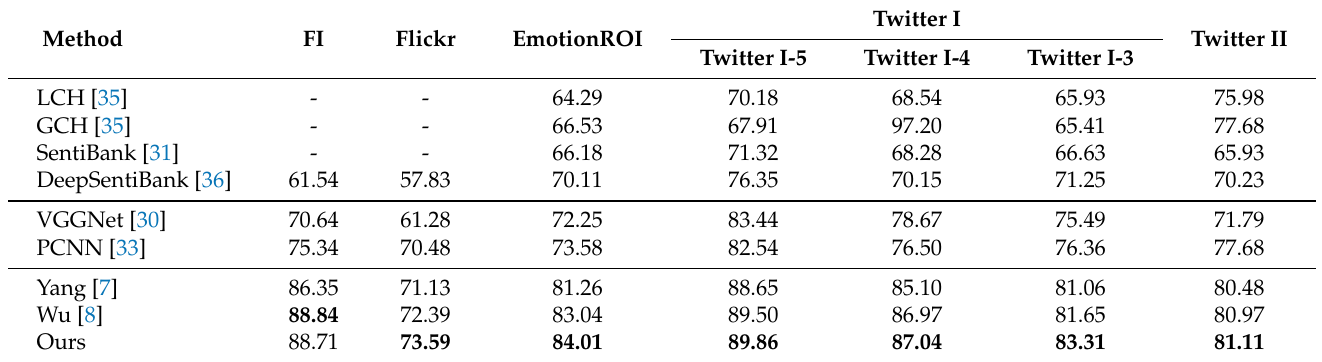
Table 1. Sentiment classification performance on the FI, Flickr, EmotionROI, Twitter I, and Twitter II datasets. The best results are indicated in bold.